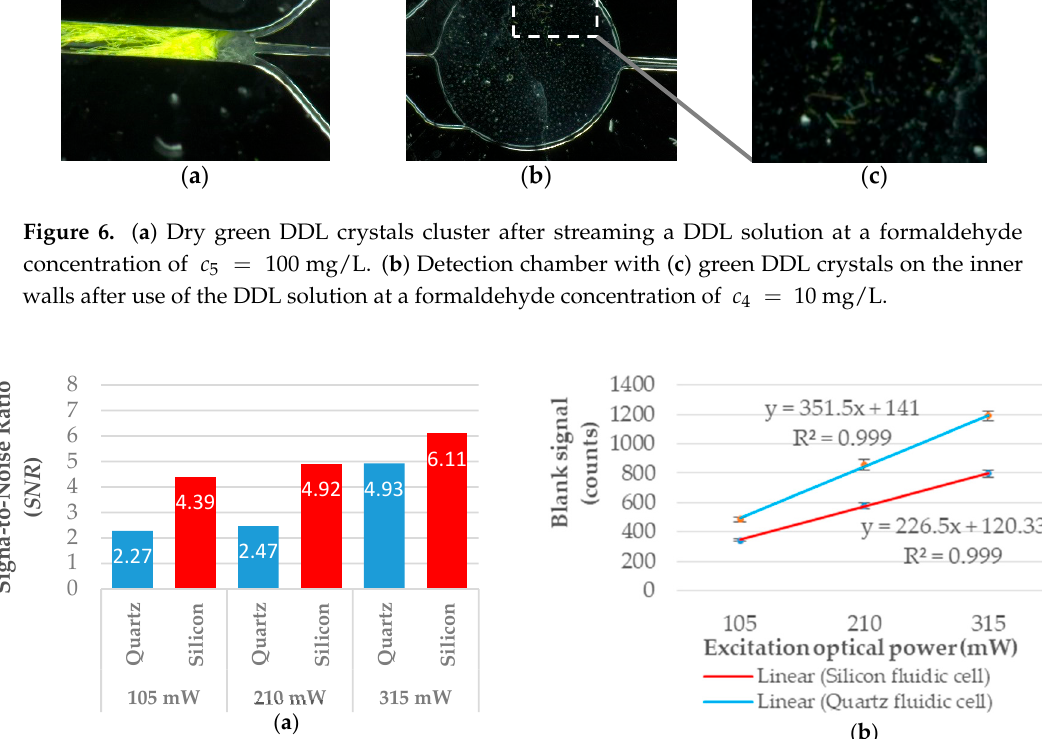
Figure 7. ( a ) Signal-to-noise ratios ( SNRs) obtained for quartz and silicon fluidic cells at a formaldehyde concentration of c 1 = 0.01 mg / L in DDL solution and with di ff erent optical powers. ( b ) The linear response obtained for three excitation optical powers at c 0 = 0.00 mg / L (blank sample). The error bars indicate the standard deviations for two independently prepared samples ( N =